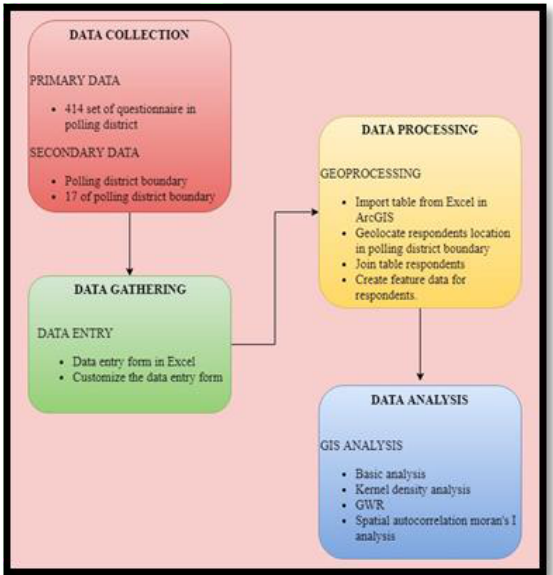
Figure 3. Overall flowchart of research methodology